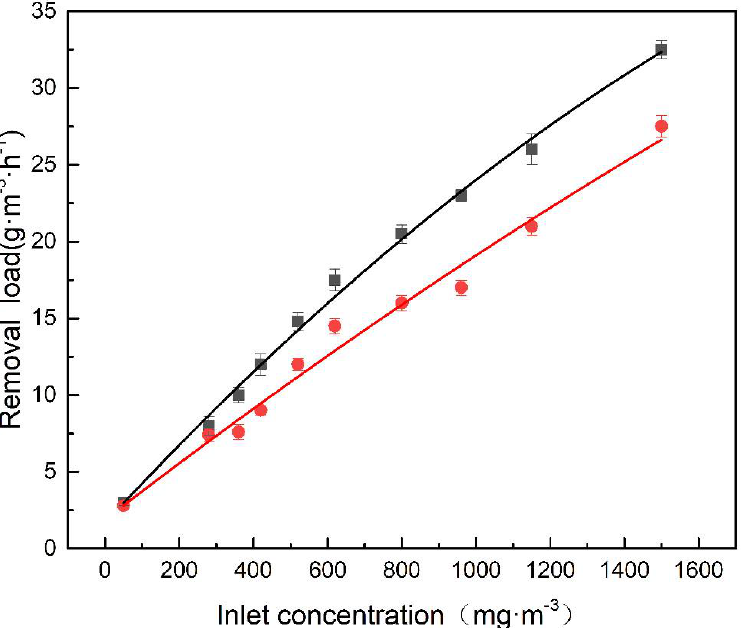
Figure 9. Comparison of chlorobenzene removal load between the integrated system and a separate biofiltration system (● Degradation efficiency of a single biofilter system, ■ Degradation efficiency of integrated system) (cycling solution density = 10.36 L·(m −3 ·s −1 ), oxygen concentration = 10%, input voltage = 7 kV, HRT of the BTF = 85 s, HRT of the DBD = 5.5 s.).